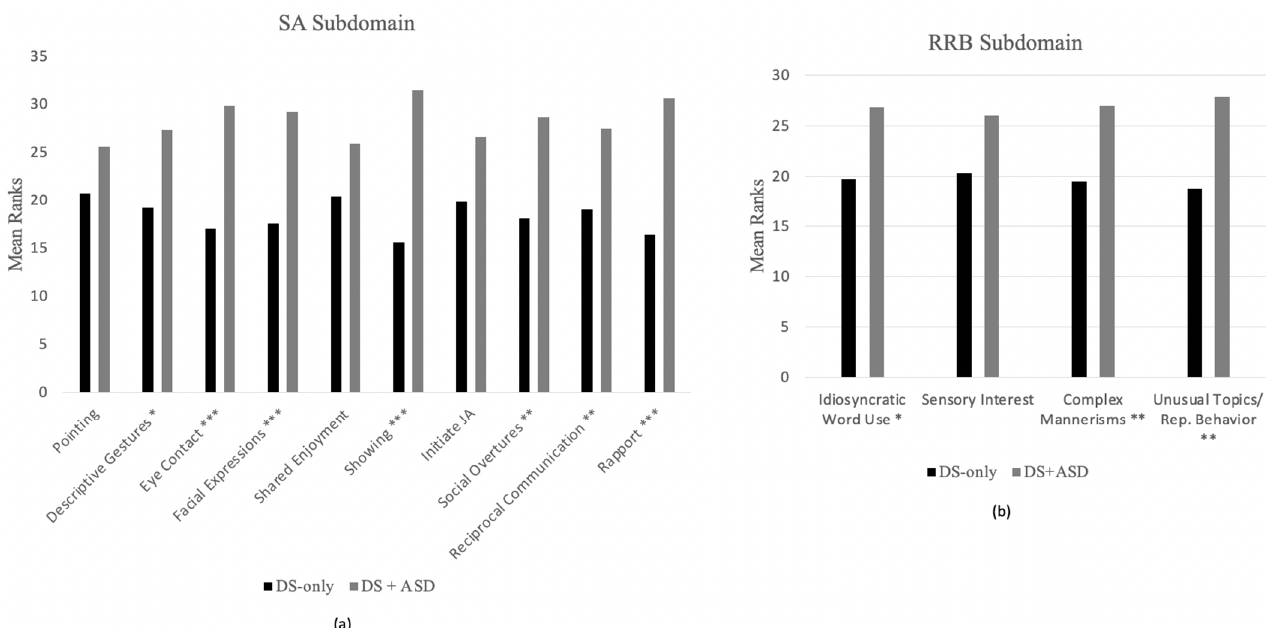
Brain Sci. 2021 , 11 , x FOR PEER REVIEW Figure 3. Mean Rank comparisons for Module 2 algorithm items; ( a ) Mean Rank comparisons for Module 2 SA items; ( b ) Mean Rank comparisons for Module 2 RRB items. Note: JA = Joint attention. * p < 0.05; ** p < 0.01; *** p < 0.001.